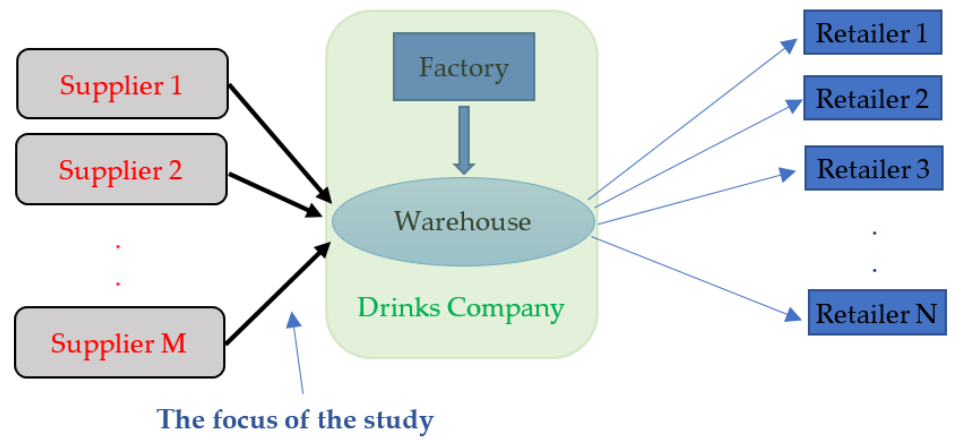
Figure 2. Drinks company supply chain.